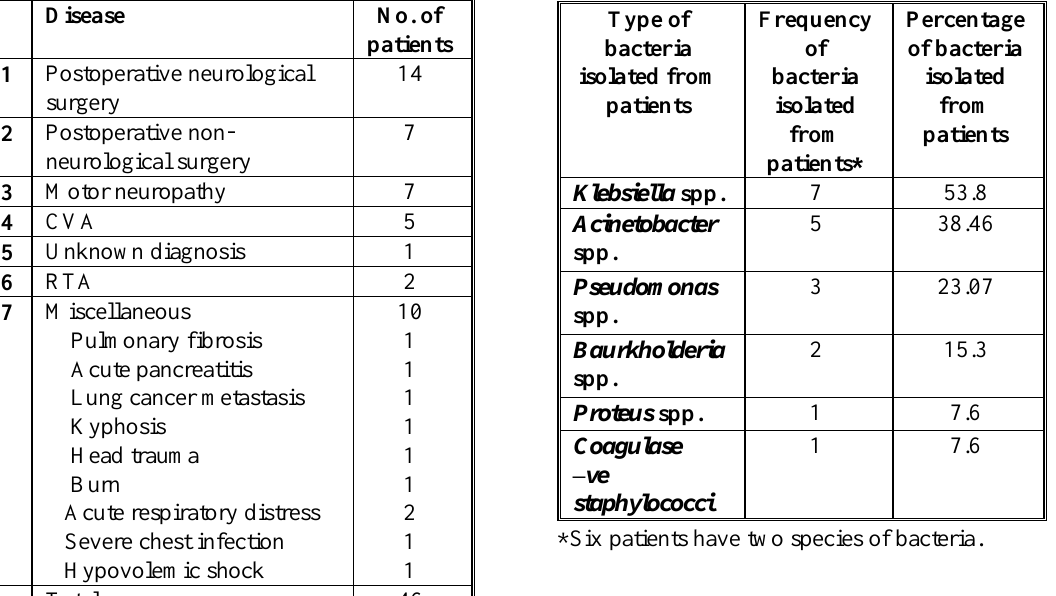
Table (2): Diseases of patients admitted to ICU.